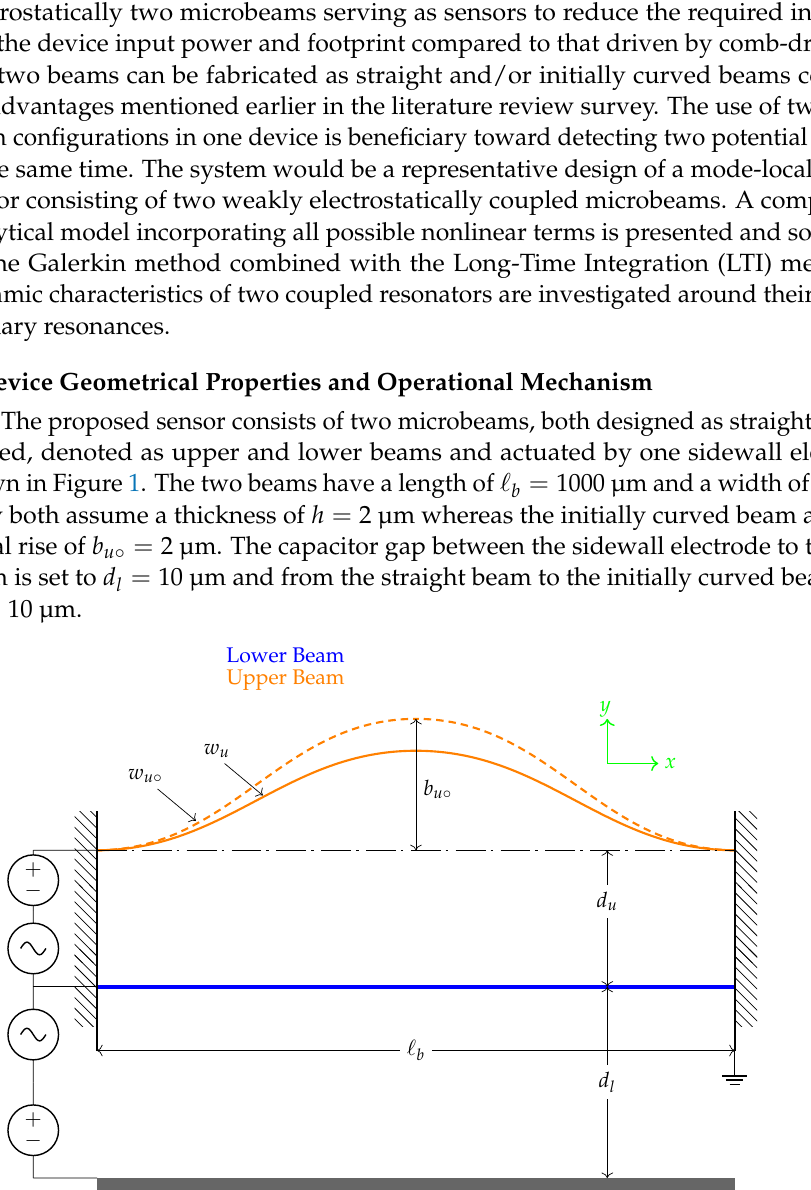
Figure 1. A schematic showing the sensor and the electrical